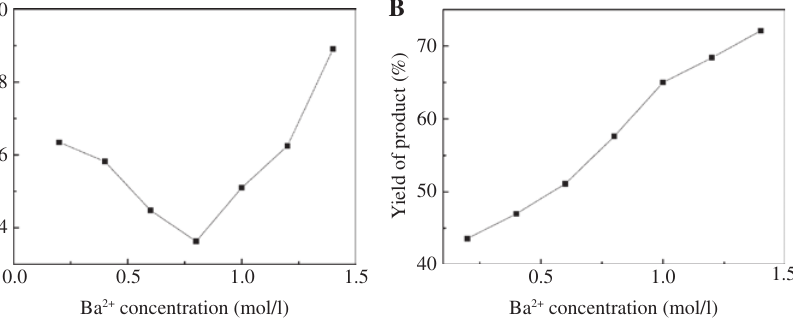
Figure 2: Effect of Ba 2 + concentration on average particle size (A) and yield of product (B), respectively, in the homogeneous precipitation.